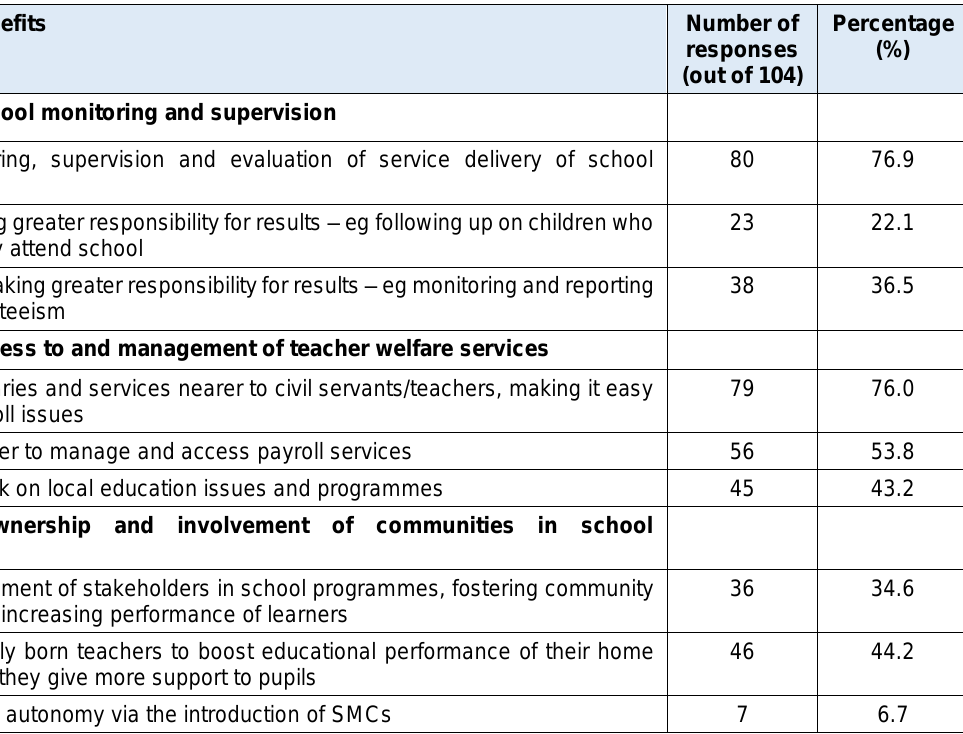
Table 1: Perceived benefits of decentralised governance of primary education Perceived